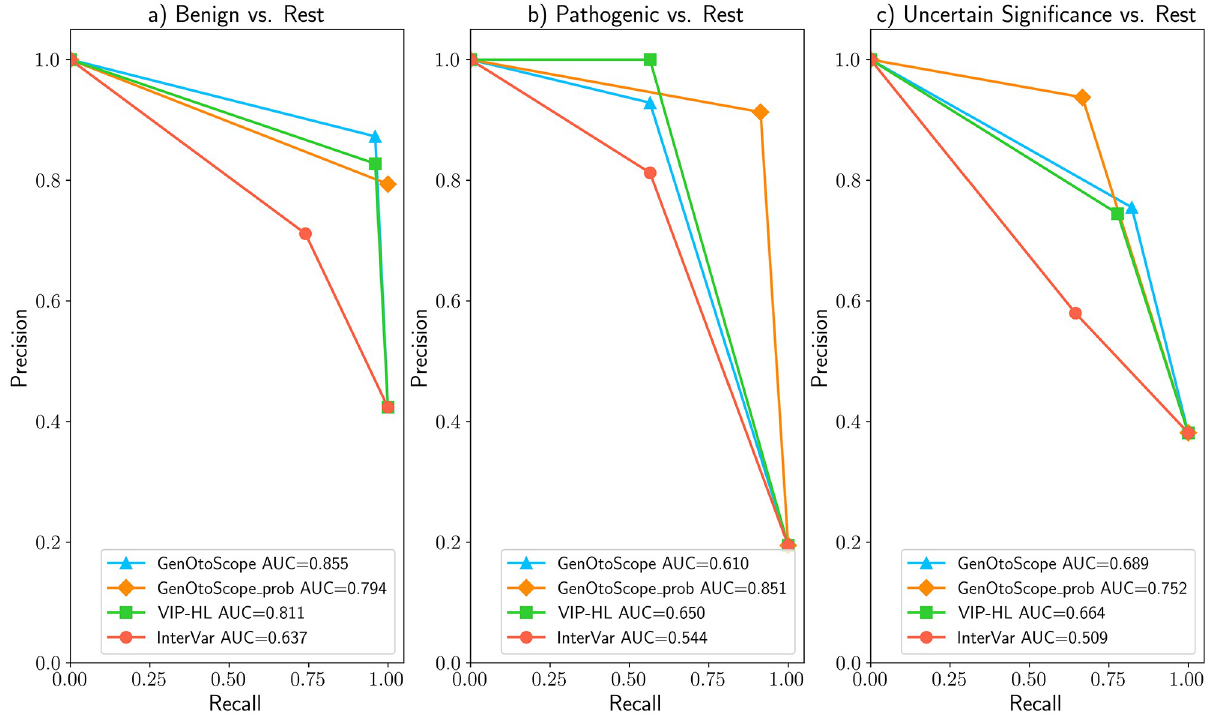
Fig 11. Precision-recall curves and AUC scores of all classification tools for the MHH data set. (A) Prediction of “Benign” broader class versus “Pathogenic” broader class and “VUS” class (B) Prediction of “Pathogenic” broader class versus “Benign” broader class and “VUS” class (C) Prediction of “VUS” class versus “Benign” broader class and “Pathogenic” broader class.